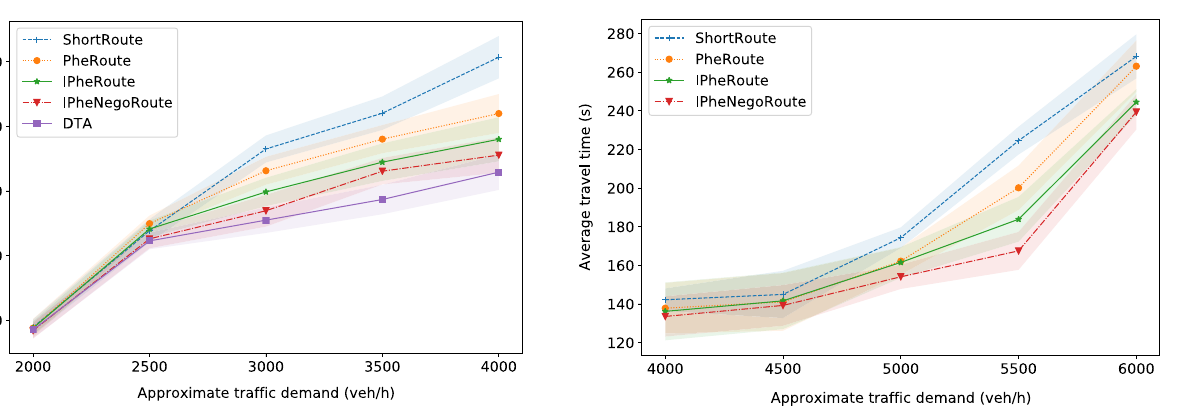
Fig. 7 Average travel time results of traffic routing methods in the Gangnam district traffic network scenario